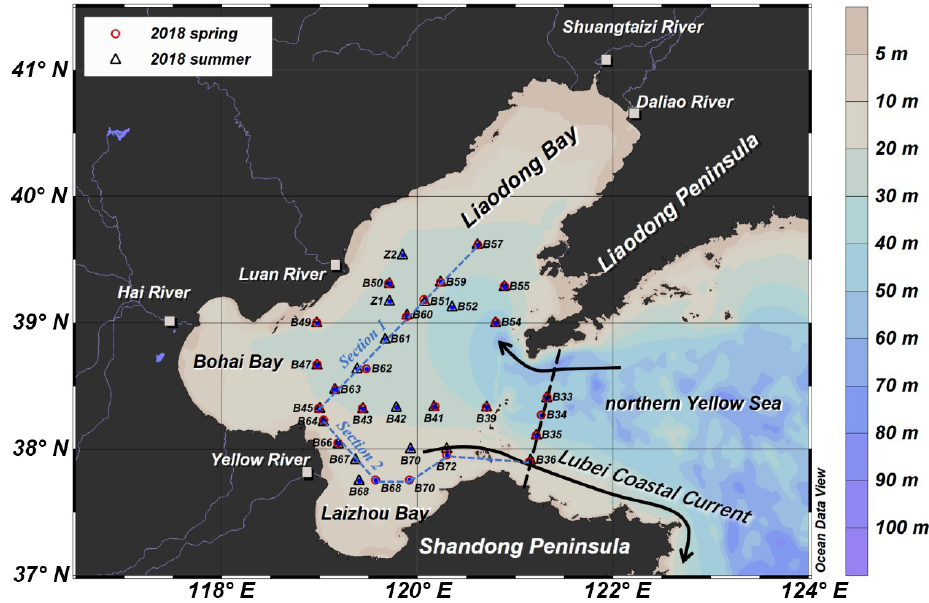
Figure 1. Sampling sites in Bohai Sea and rivers (Xiaoqing River not shown). Open red circles stand for sampling sites in spring, and open blue triangles stand for sampling sites in summer; names of the sites are marked nearby. Black arrows stand for the most significant current flows in and out of the BHS. Dashed blue lines stand for two main sections, and the dashed black line stands for the boundary of our study area. (Base map sourced by Ocean Data View, https://odv.awi.de, Schlitzer, 2021)